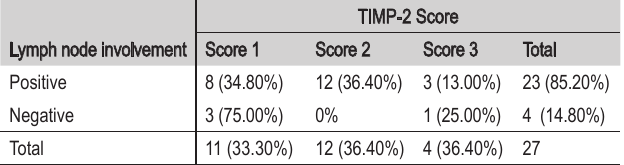
Table 3 - Association of TIMP-2 expression score and lymph node metastases in OSCC (p= 0.176).